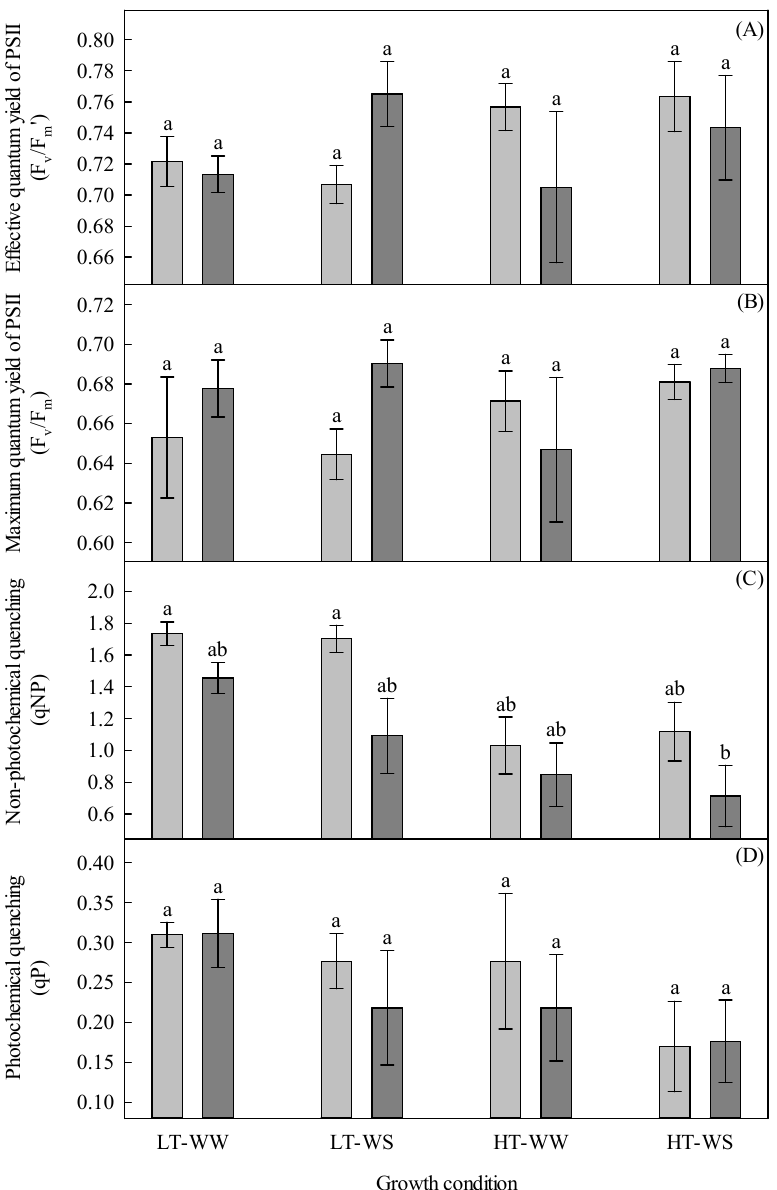
Figure 5. Chlorophyll fluorescence of 33-day-old tomato plants grown under eight experimental conditions including two temperature regimes, two watering regimes, and two abscisic acid concentration applications after 12 days of initial germination and growth in growth chambers with lower temperature, watering to field capacity, and without abscisic acid application. ( A ) Effective quantum yield of PSII ( Δ F/F m ’), ( B ) maximum quantum yield of PSII (F v /F m ), ( C ) non-photochemical quenching (qNP), and ( D ) photochemical quenching (qP). LT, lower temperature; HT, higher temperature; WW, well-watered; WS, water stressed; light gray, no abscisic acid; dark gray, abscisic acid. Data are the means ± SE of 48 samples from two experiments. Bars with different letters above them are significantly different according to Scheffé’s multiple comparison procedure at the 5% confidence level.